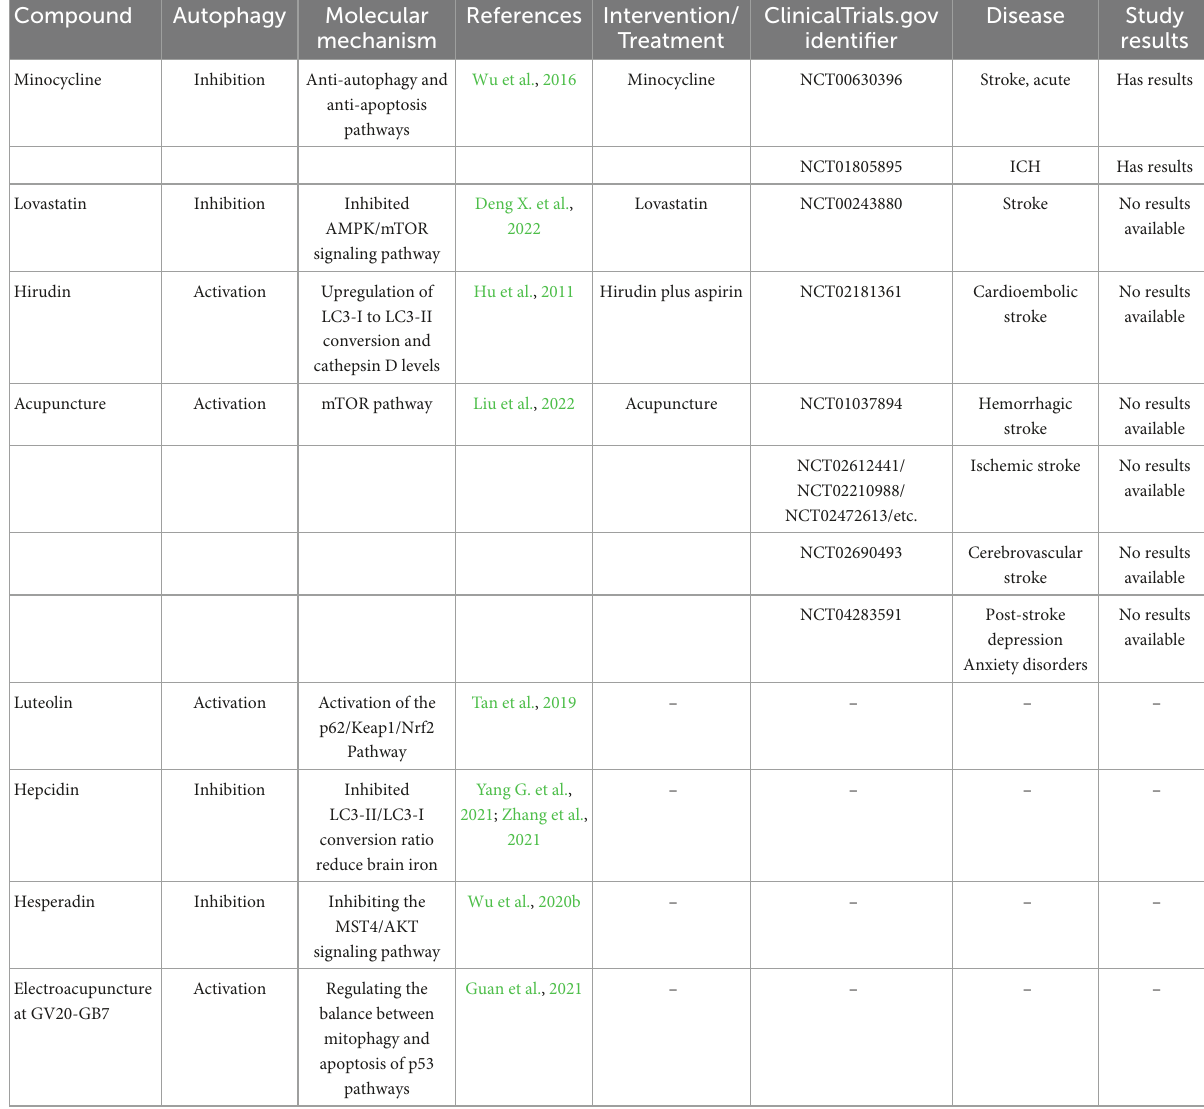
TABLE 4 Autophagy-related compounds in ICH and these compounds or treatment in clinical trials for stroke reported (https://www.clinicaltrials.gov/).